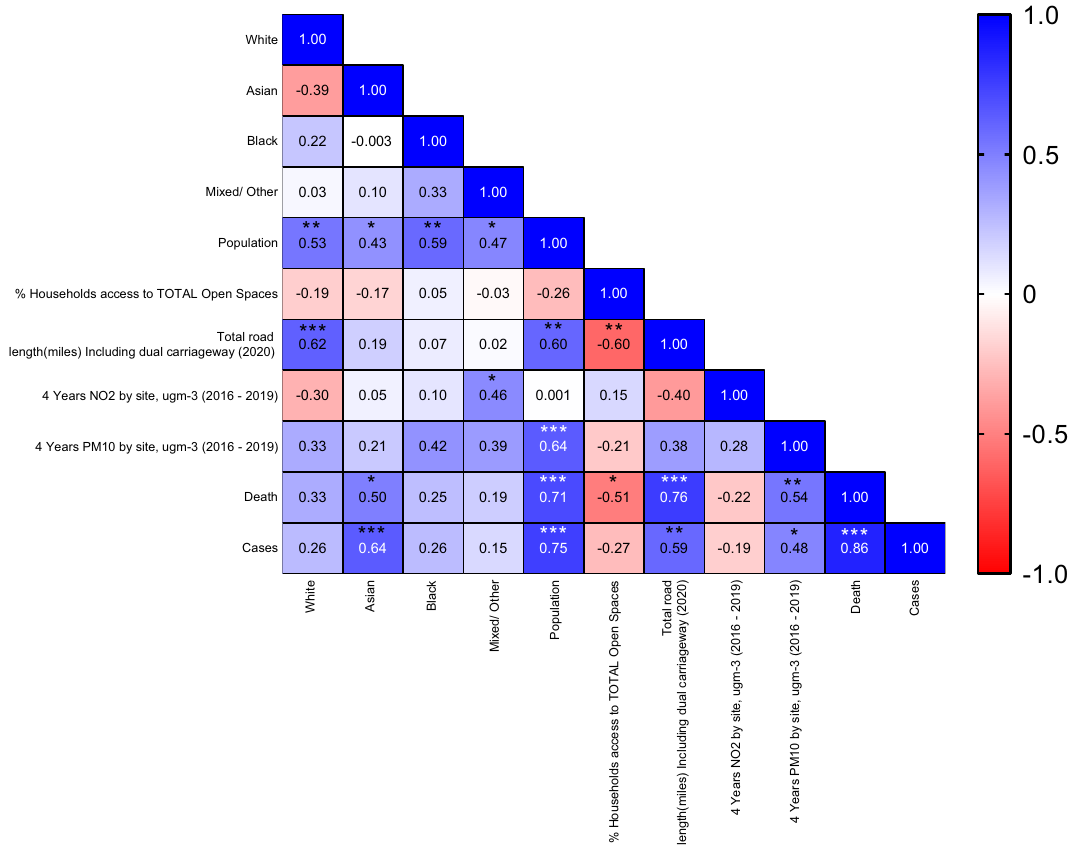
Figure 1. Heatmap displaying Pearson correlation analysis R values and p-values between all variables across 32 London boroughs ( p * ≤ 0.0137, ** ≤ 0.001, *** ≤